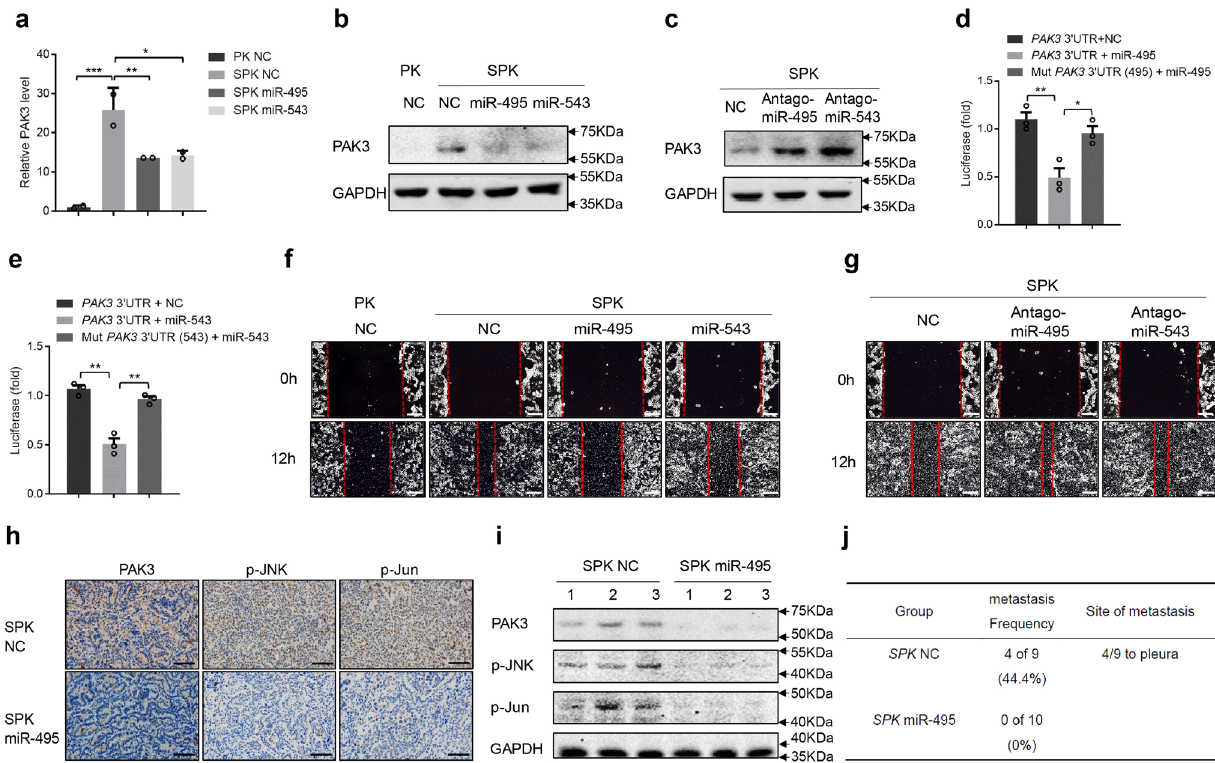
Fig. 6 MiR-495 and miR-543 directly bind to the PAK3 3 ′ UTR and attenuate the metastatic potential of lung cancer cells in vitro and in vivo. a , b The expression of PAK3 was detected at both mRNA and protein levels after SPK cells were transfected with miR-495 or miR-543 mimics. Data presented are the mean ± SD from three biologically independent samples ( n = 3). *** p = 0.000448037; ** p = 0.007514536; * p = 0.009195246. c The expression of PAK3 in SPK cells was detected following the transfection with miR-495 or miR-543 inhibitors (antagomiR-495 or antagomiR-543) and the experiment was repeated three times independently with similar results. d , e PAK3 3 ′ UTR and its mutation luciferase report system were constructed. The activity of the luciferase reporter bearing the WT 3 ′ UTR of PAK3 was measured in H1299 cells transfected with miR-495 or miR-543 mimics. Luciferase activity means the expression level of PAK3 3 ′ UTR. Data presented are the mean ± SEM from three biologically independent samples ( n = 3); ** p = 0.007393441 ( d ); * p = 0.018265986 ( d ); ** p = 0.001333882 ( e ); * p = 0.002263372 ( e ); as determined by two-tailed Student ’ s t -test. f Cells were made a wound between the two red dashed lines, the area of the two red dashed lines represent the level of wound healing and the cell migration activity. Cell migration ability was detected by wound healing assay in PK, SPK, SPK miR-495, and SPK miR-543 cells, and the experiment was repeated three times independently with similar results. Scale bar, 100 μ m. g Cell migration ability was detected by wound healing assay after antagomiR-495 or antagomiR-543 was introduced into SPK cells, and the experiment was repeated three times independently with similar results. Scale bar, 100 μ m. h – j Six-eight weeks SPK mice were treated by adeno-Cre and then injected NC agomir ( n = 9) or miR-495 agomir ( n = 10) after 4 weeks, once every 2 weeks. After 8 weeks, all mice were sacri fi ced to check lung cancer metastasis ( j ) and collected lung tumors to test the expression level of PAK3, p-JNK, and p-Jun, these representative mouse samples were shown by IHC ( h ), and Western blotting ( i ). Scale bar, 25 μ m (magni fi cation,